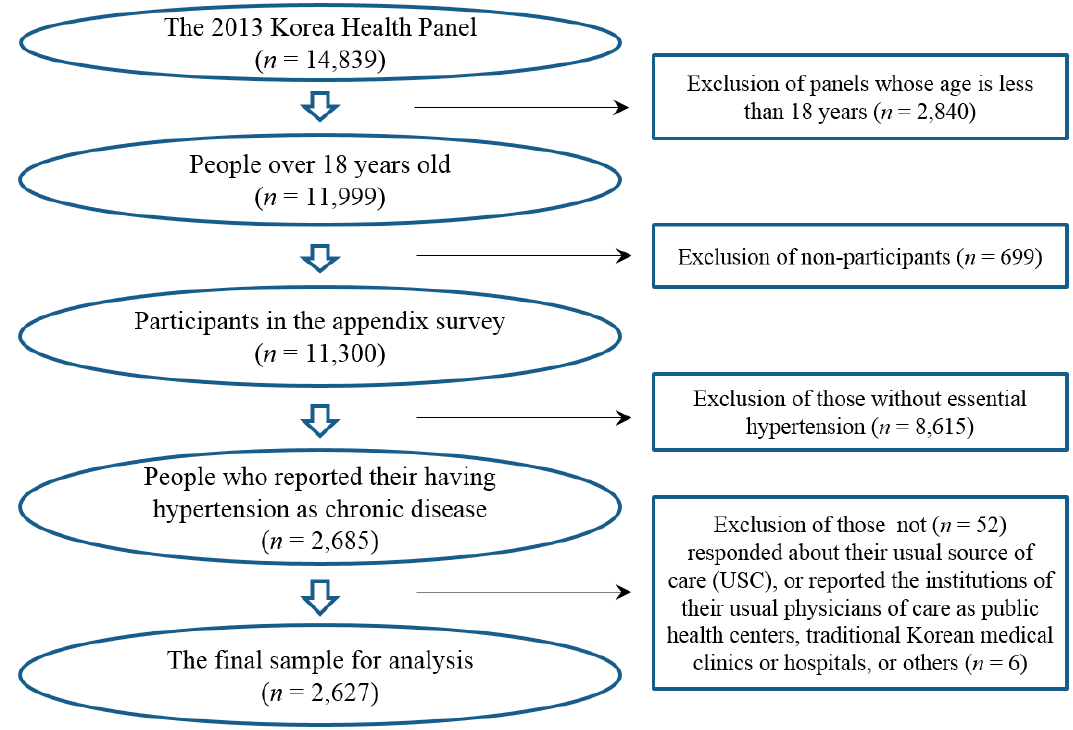
Figure 1. Sample selection process in this study.